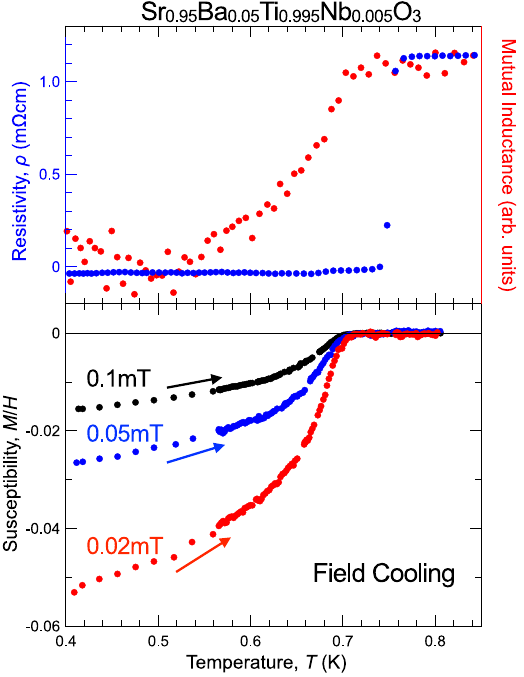
Fig. 5 T c comparison: resistivity, mutual inductance, and diamag- netism. The top panel shows the superconducting transition observed via the AC mutual inductance (closed red circles) for Sr 0.95 Ba 0.05 Ti 0.995 Nb 0.005 O 3 (same sample in Fig. 3c) below 0.9 K in comparison with the resistive transition (closed blue circles) for the same sample. Although there must be a Joule heating effect due to the movement of the magnetic fl uxes within the sample, the T c value that is de fi ned as the onset of the mutual inductance drop (0.70 K) is almost equal to the corresponding resistive value (0.75 K). The bottom panel shows the DC volume magnetic susceptibility (Meissner effect) measured during warming after fi eld cooling (FC) at 0.02, 0.05, and 0.1 mT for the same sample. The T c value (0.70 K) that is de fi ned as the onset of diamagnetism nearly coincides with the zero resistivity temperature. (We have subtracted the back- ground contributions here. See the Methods for full metals. When the carrier density n < n *, the resistance shows an anomaly at T K , which increases monotonically as the carrier density decreases and coincides with the ferroelectric Curie temperature at the zero carrier density limit. Although the values of n * for Nb:Sr 0.985 Ca 0.015 TiO 3 and Nb:Sr 0.95 Ba 0.05 TiO 3 are different by one order of magnitude, both materials show typical single superconducting domes with peaks commonly located around 10 20 cm − 3 . When compared with that of nonpolar Nb:SrTiO 3 , the values of T c are enhanced up to 0.75 K. However, the increase in T c was not signi fi cant (less than 0.1 K) at around n *. This enhance- ment becomes much more prominent as we go deeper into the polar metal region. Space-symmetry breaking not only coexists